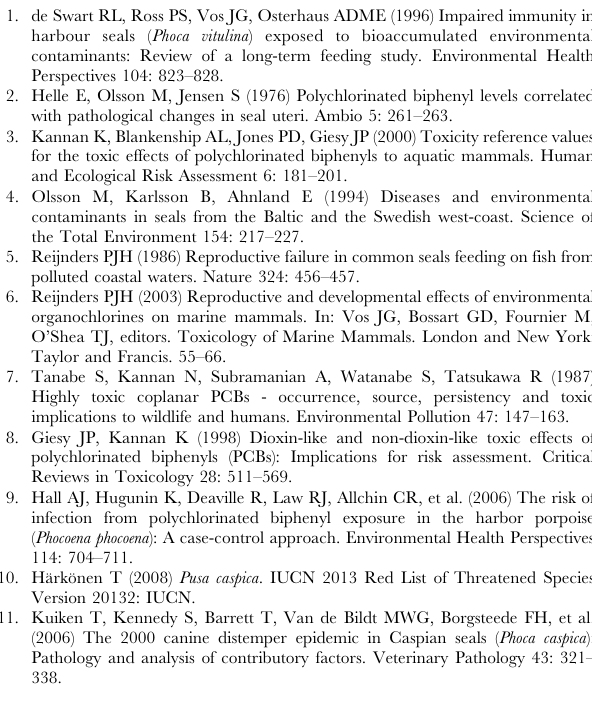
line) Caspian seals. Table S3. Linear model comparison for PCBs ranked by AIC score. Table S4. Linear model comparison for DDTs ranked by AIC score. Figure S3. Boxplots showing variation in PCBs and DDTs for Country, Season and Year. Figure S4. Plots for analysis of blubber thickness. Figure S5. Plots for regression comparisons of PCBs and DDTs. Table S5. Results of general linear binomial model with logit link function, assessing contributions of organochlorine burden, blubber thickness and sex to CDV status. Figure S6. Photograph showing a high density moulting aggregation of Caspian seals in Komsomoletz Bay,